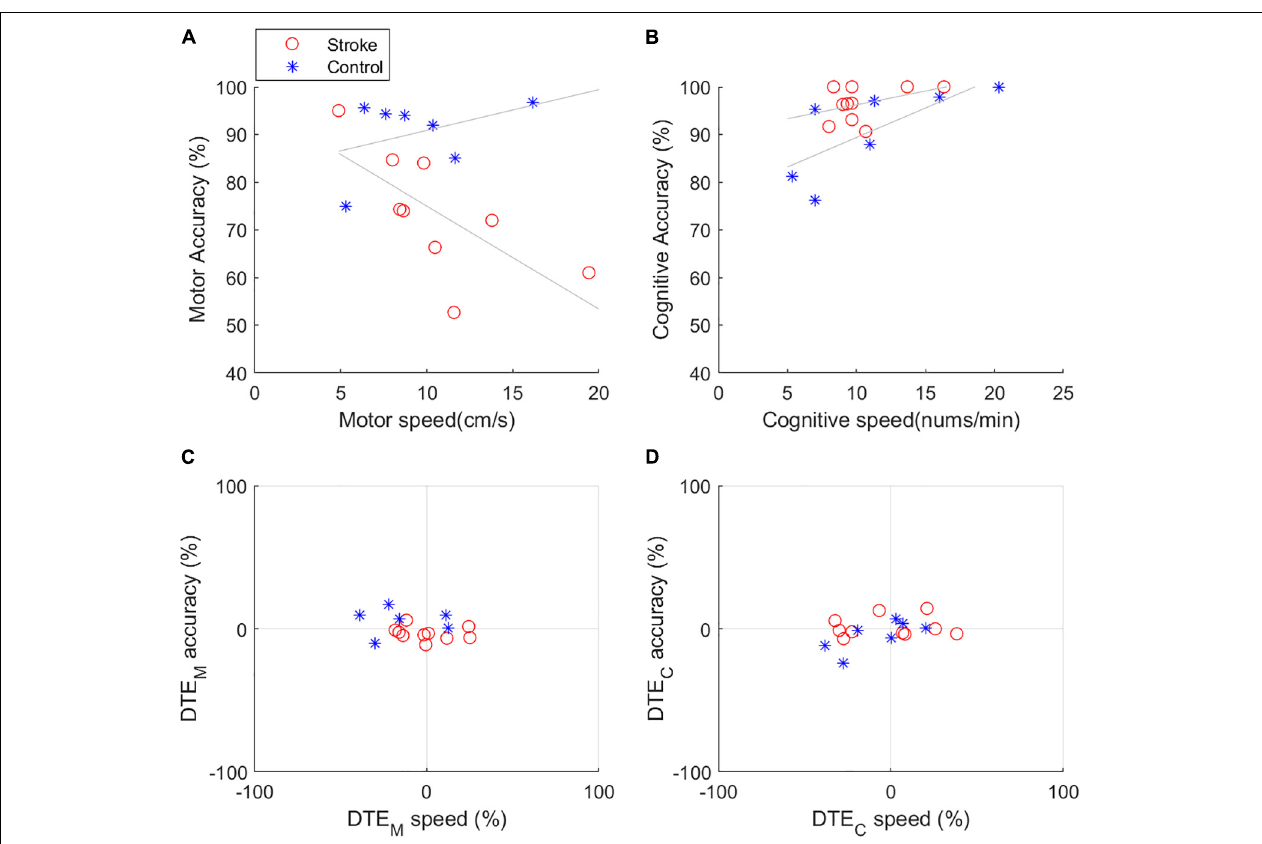
FIGURE 2 | Dual task effects on speed and accuracy during cognitive (COWAT) and upper limb motor (Cross) dual task (A) Speed and accuracy relationship in motor task (B) Speed and accuracy relationship in cognitive task (C) DTE motor speed and accuracy (D) DTE cognitive speed and accuracy.